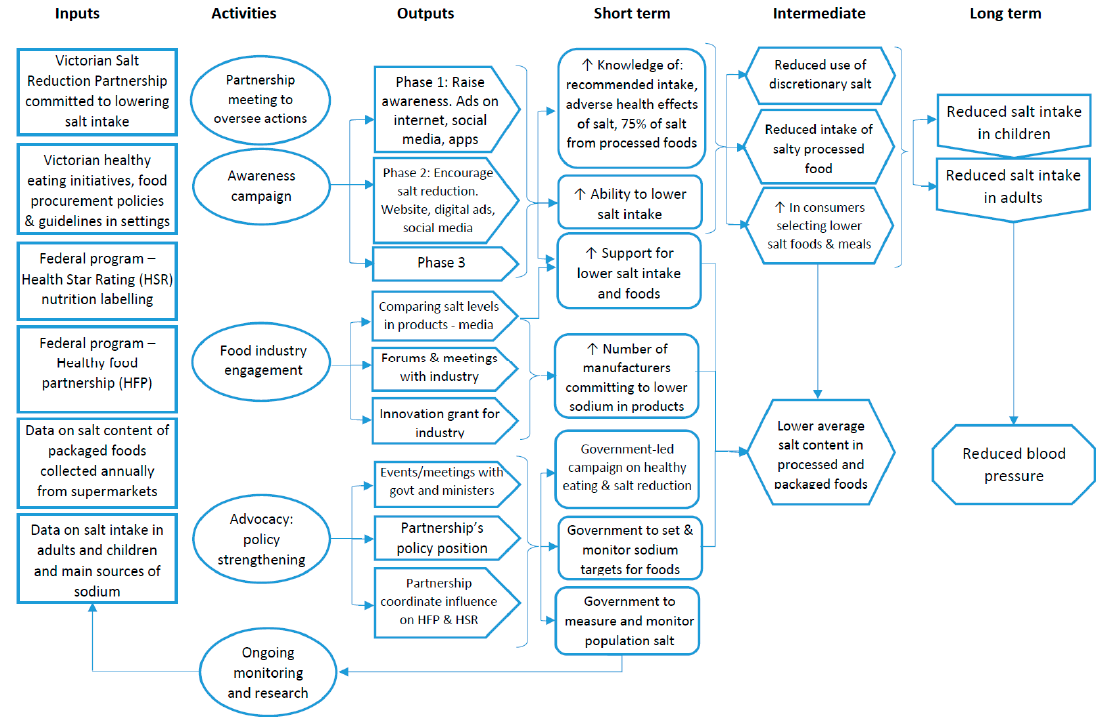
Figure 1. Logic model of the Victorian Salt Reduction Partnership program of interventions.